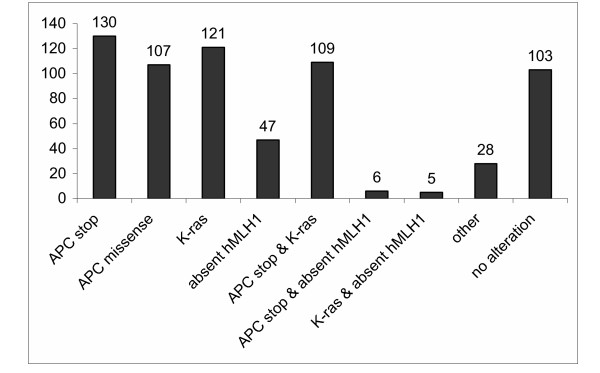
Distribution of aberrations in the APC and K-ras genes and hMLH1 expression in 656 colorectal tumours. The data in this figure are based on tumours from 656 sporadic colorectal cancer patients. The bars representing the different molecular alterations represent mutually exclusive groups of tumours. The category "Other" includes; APC silent mutation (n = 25), K-ras mutations other than missense mutations in codons 12 and 13 (n = 2), and both of these (n = 1).